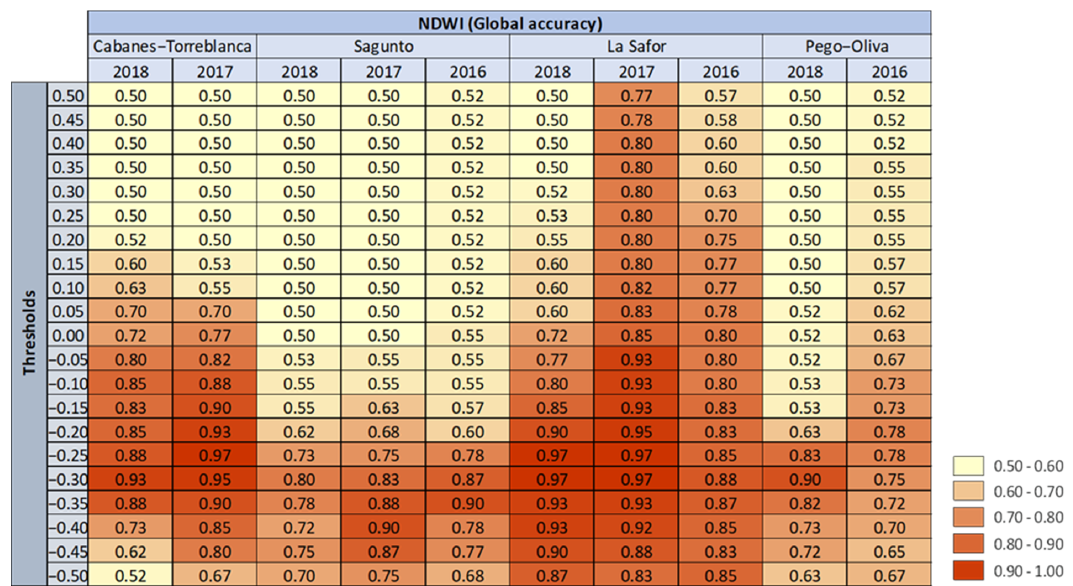
Figure 6. Overall accuracy of NDWI index tested at four studies areas and 3 years for the threshold range ( − 0.50 to 0.50).